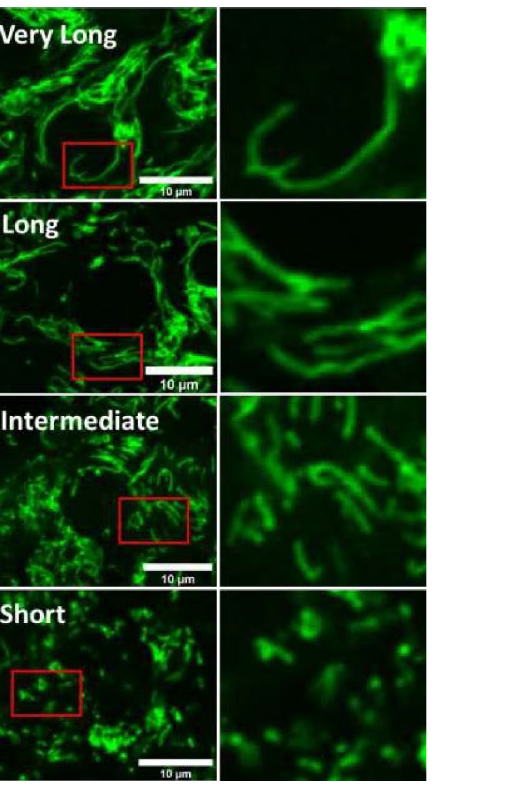
Figure 1. Staining of active mitochondria. ( A ) Images of cumulus cells stained with TMRM and observed live with confocal microscopy at 63X (n = 3). Different mitochondrial network structures in cumulus cells were observed. ( B ) Mitochondrial network phenotype evaluation in each cumulus cell (n = 3, mean ±